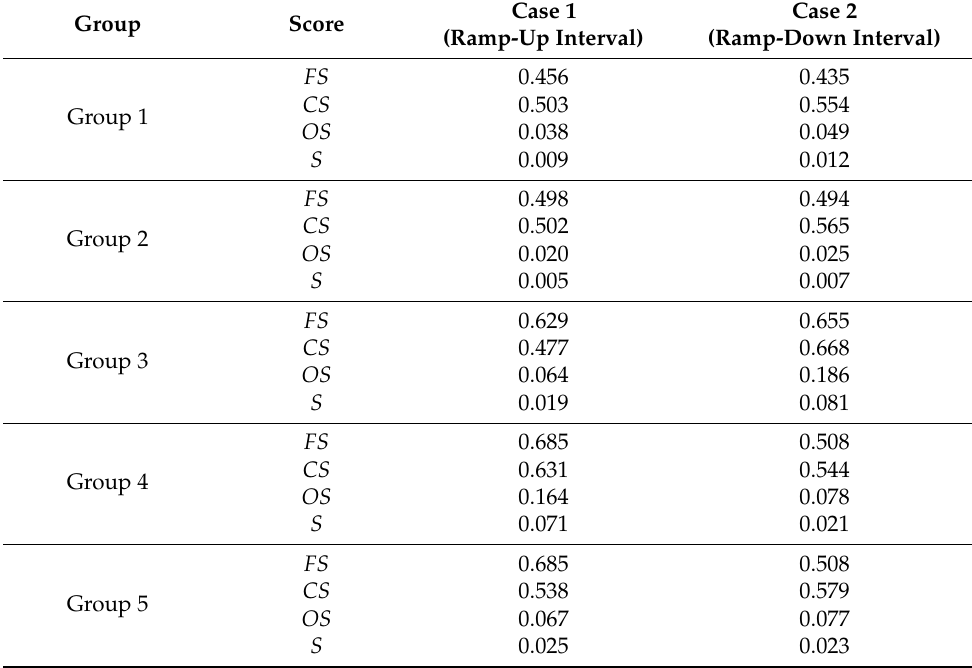
Table 2. Flexibility score result (season: winter; resources: groups 1 to 5).